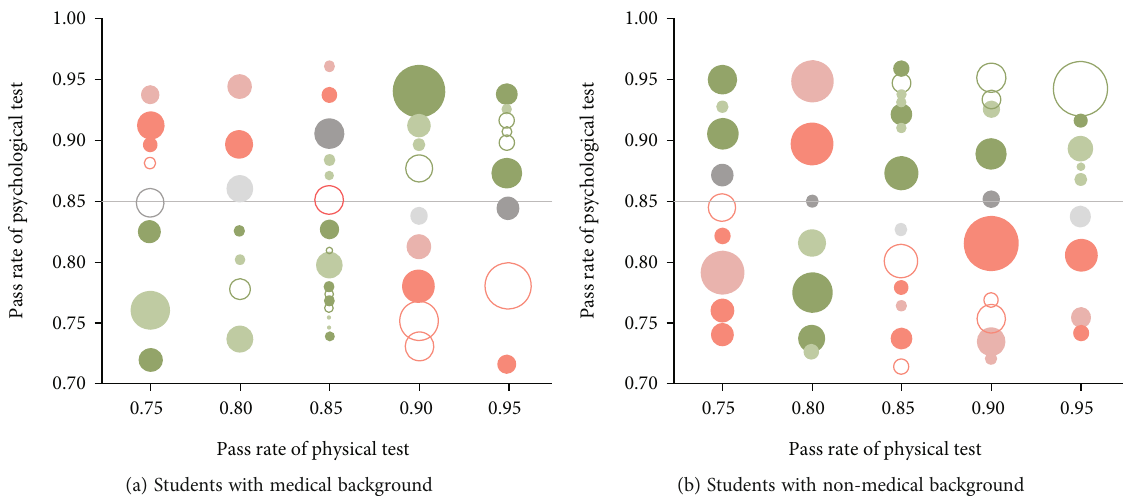
Figure 3: Relationship between pass rate of psychological test and physical test of students with (a) and without (b) medical background based on multidimensional data